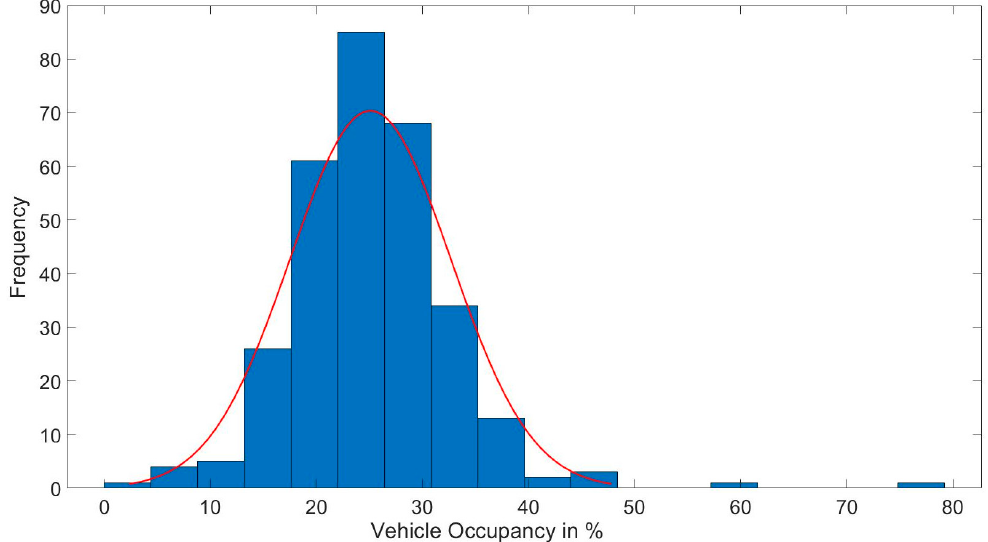
Figure 4. Frequency distribution of passenger occupancy for all simulated vehicle departures.